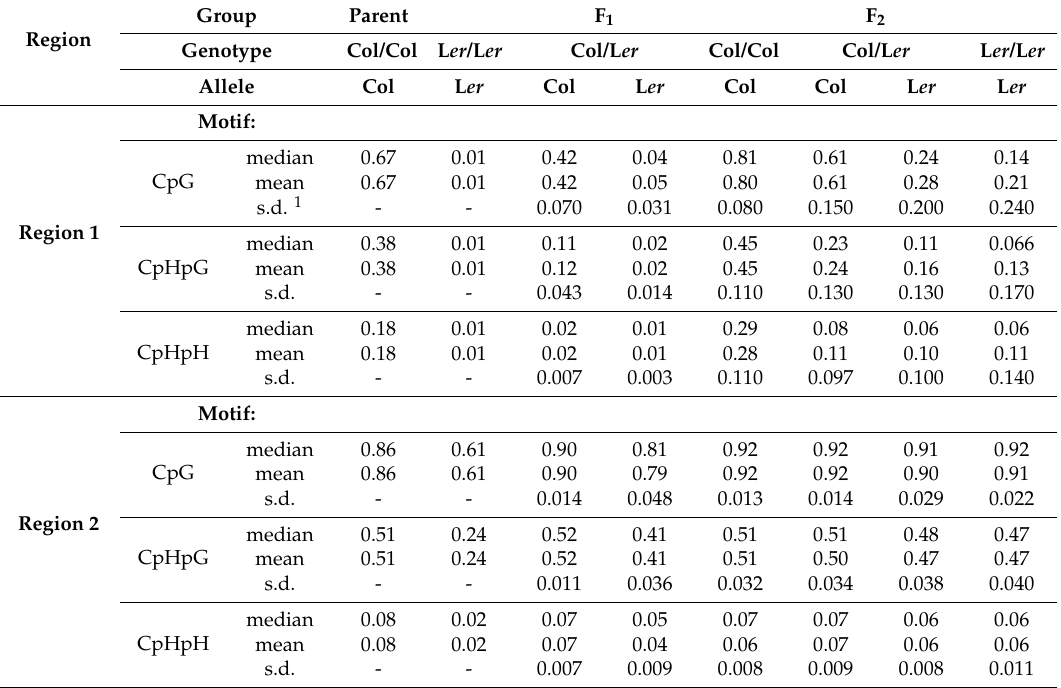
Table 2. Diversification of DNA methylation level.